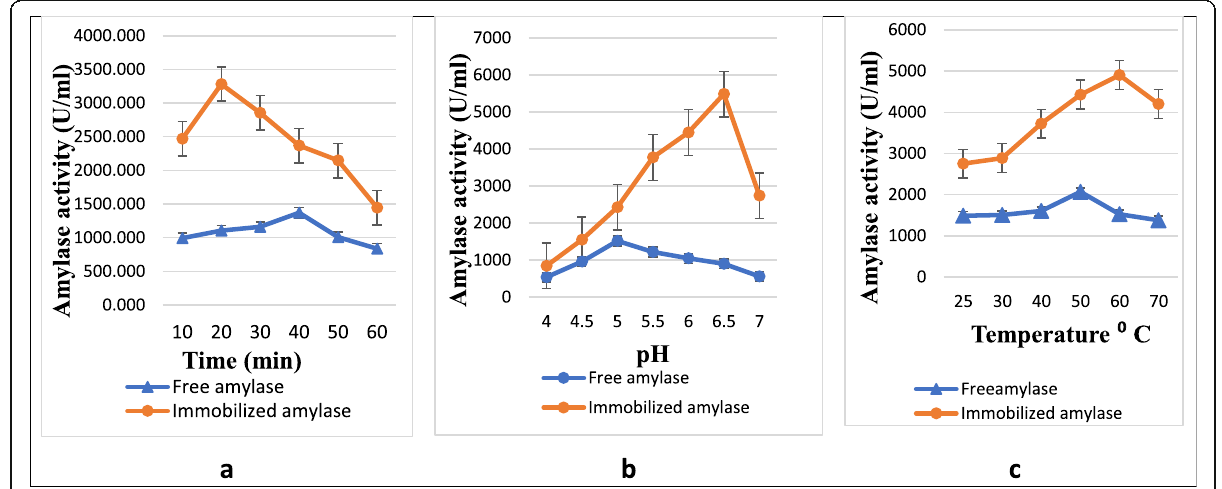
Fig. 7 Effect of different reaction time ( a ) different pH ( b ), and different temperature ( c ) on the activity of free and immobilized